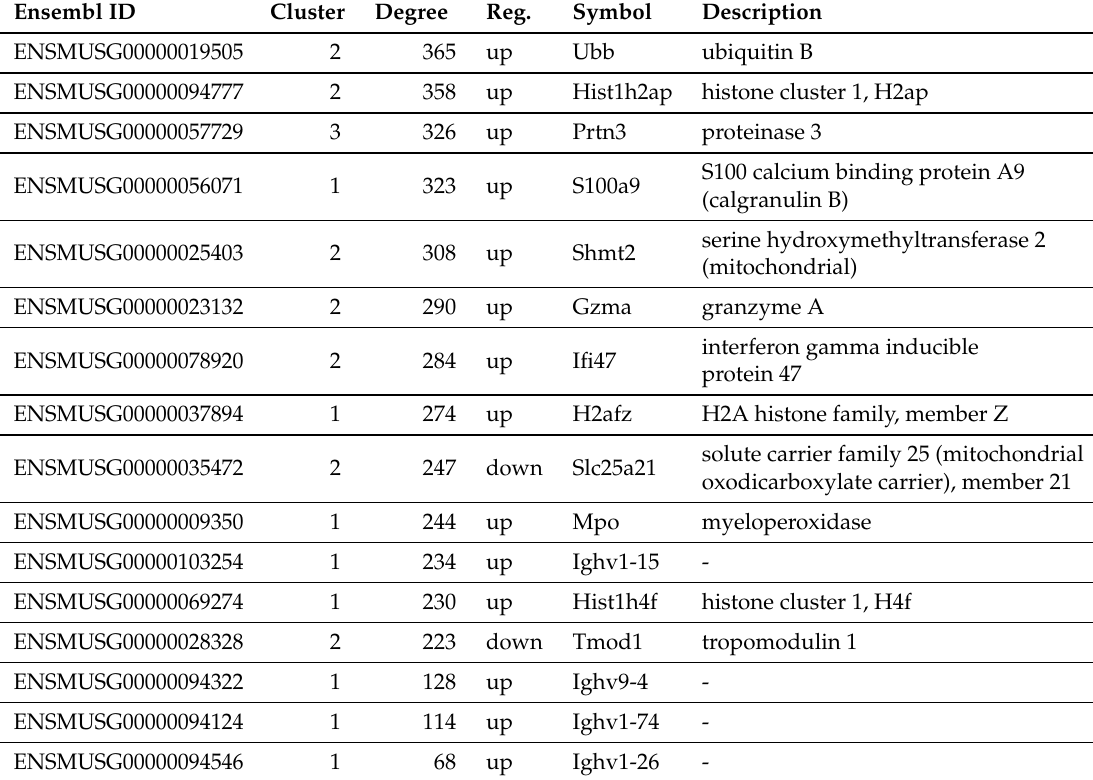
Table A4. Hubs identified in the network reconstructed from spleen wt samples. Degree cutoff: 21. Reg.